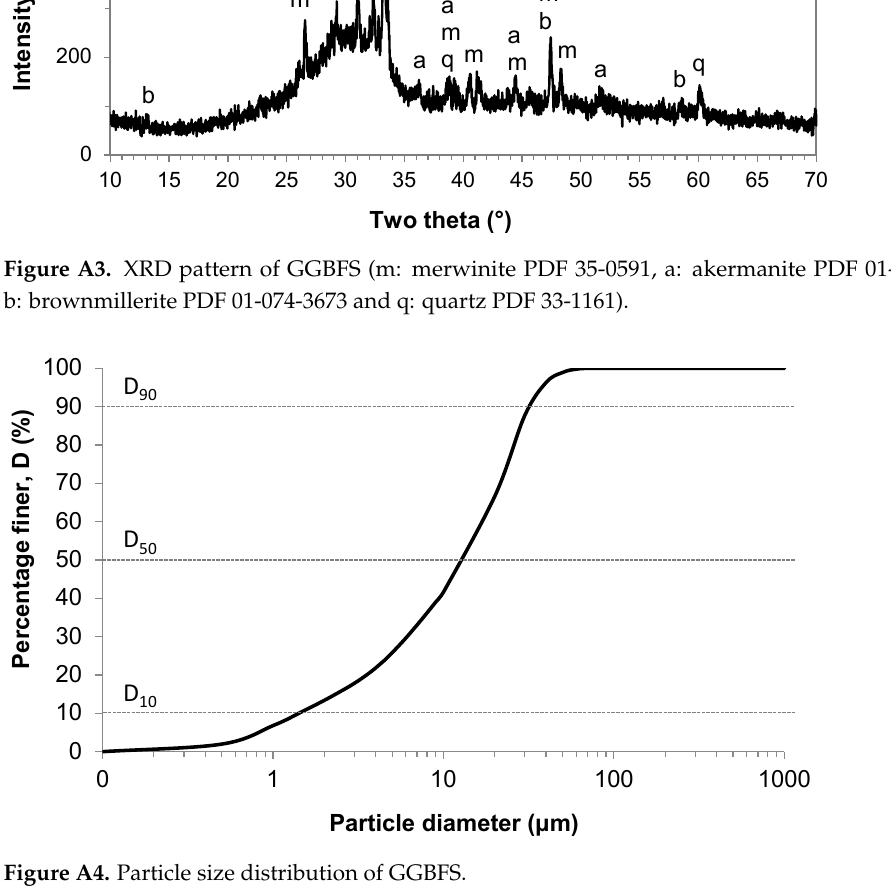
20 of 23 Figure A1. XRD pattern of MK (q: quartz PDF 33-1161 and c: cristobalite PDF 39-1425).